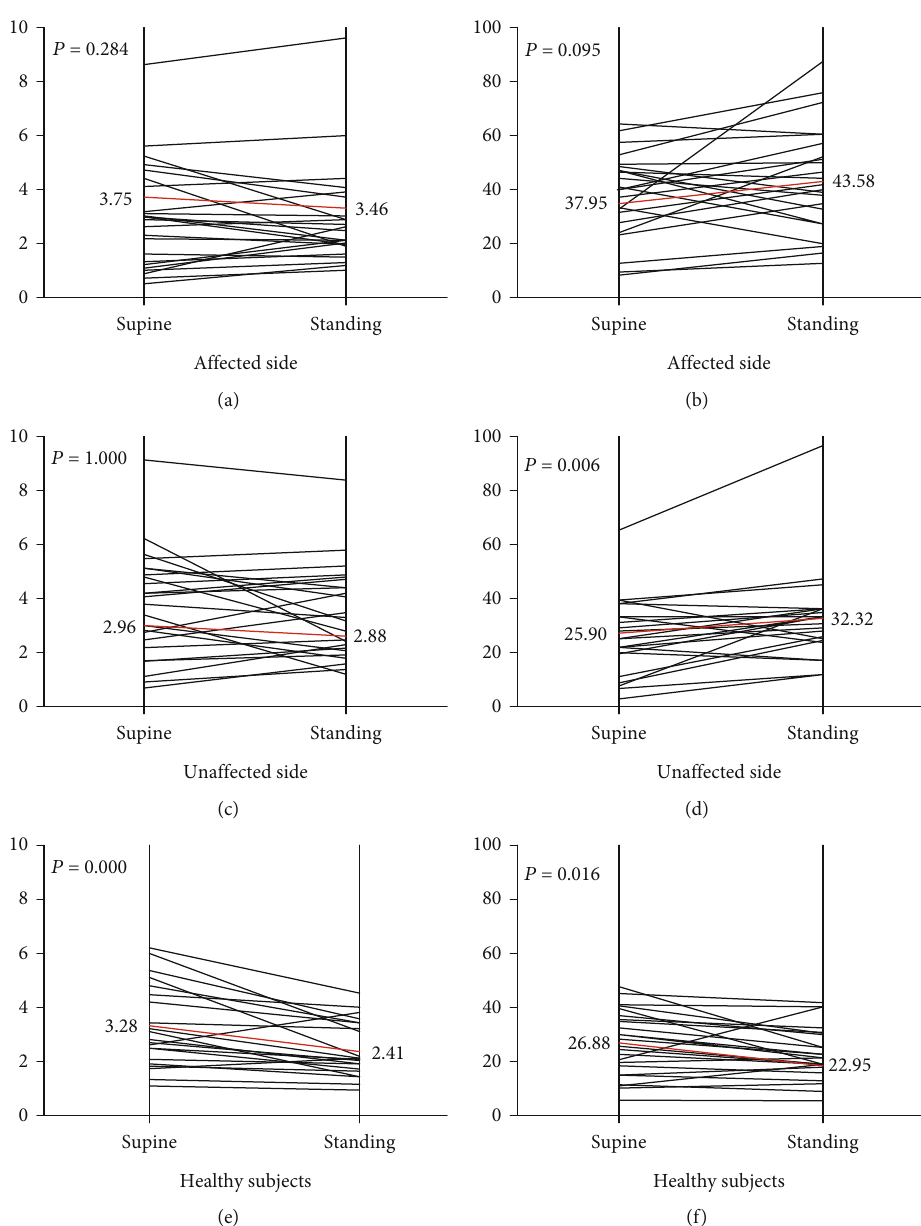
Figure 3: The individual results of H-re fl ex on the a ff ected side (a, b), the una ff ected side (c, d) of stroke patients, and in healthy subjects (e, f) from the prone position (left panels) to the standing position (right panels). (a, c, e) Hmax. (b, d, f) Hmax/Mmax ratio. The individual values (thin line) and mean (thick red line, values indicated beside the vertical line) obtained on the a ff ected and una ff ected sides from 24 stroke patients and 12 healthy